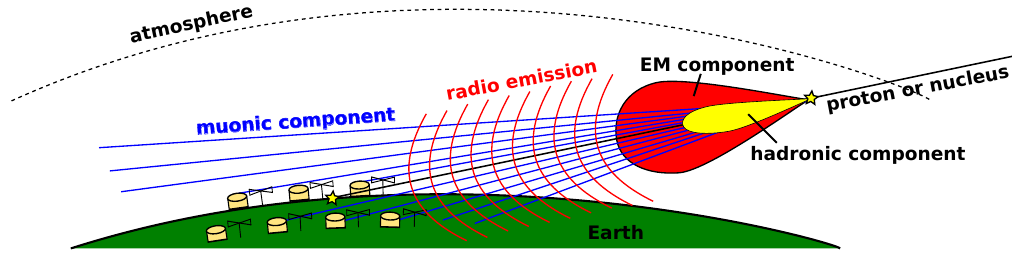
Figure 2. Illustration of a horizontal air shower. The hadronic and electromagnetic component is absorbed and the muonic component and the radio signal can be measured on the ground. [5,